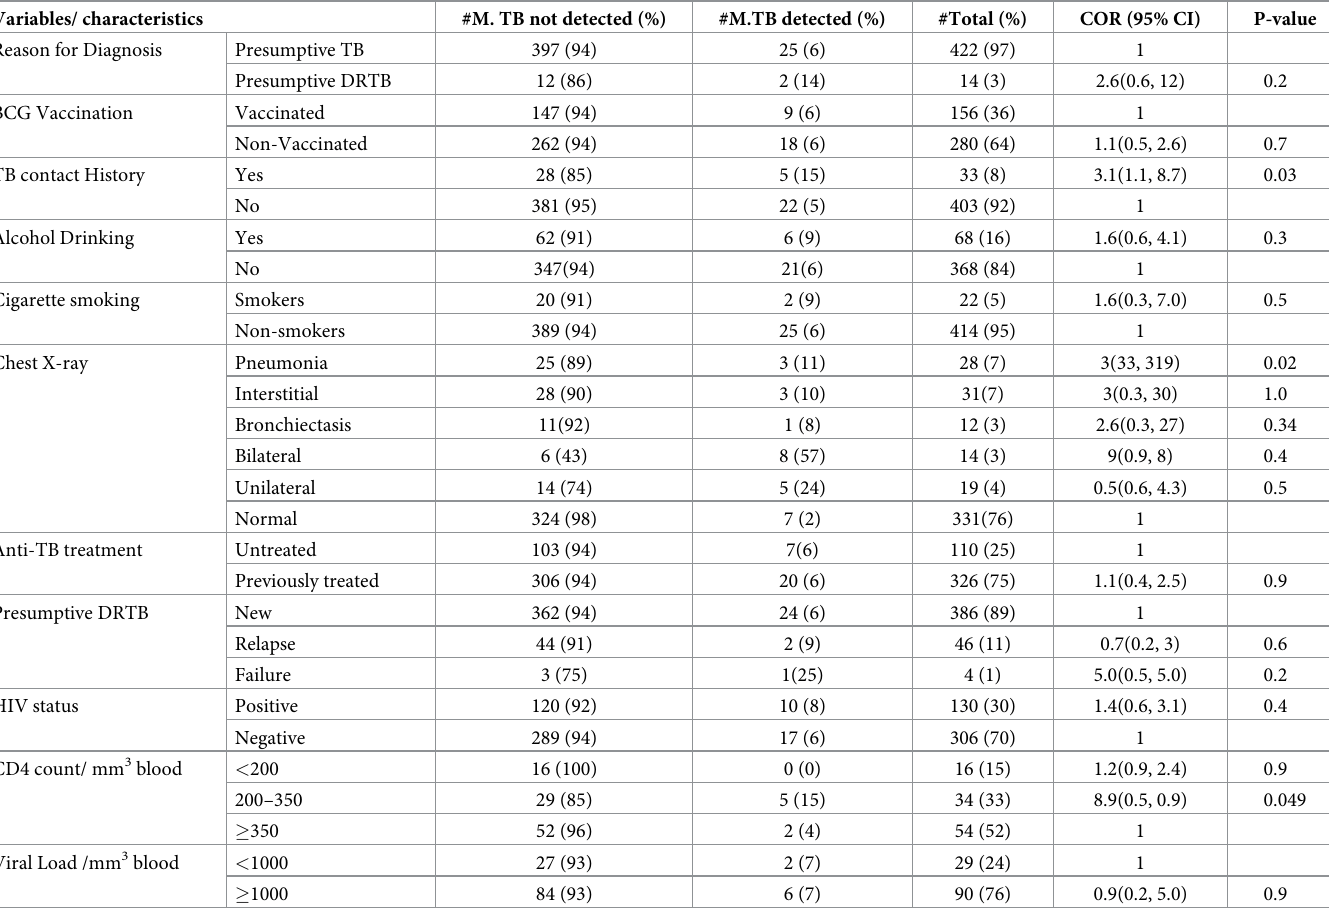
Table 4. Clinical factors associated with magnitude of M . tuberculosis among presumptive TB patients at SPHMMC, Addis Ababa, Ethiopia, 2019. Variables/